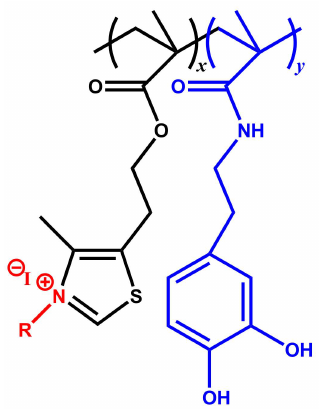
Figure 1. Chemical structure of quaternized copolymers P(DOMA x -co-MTA y